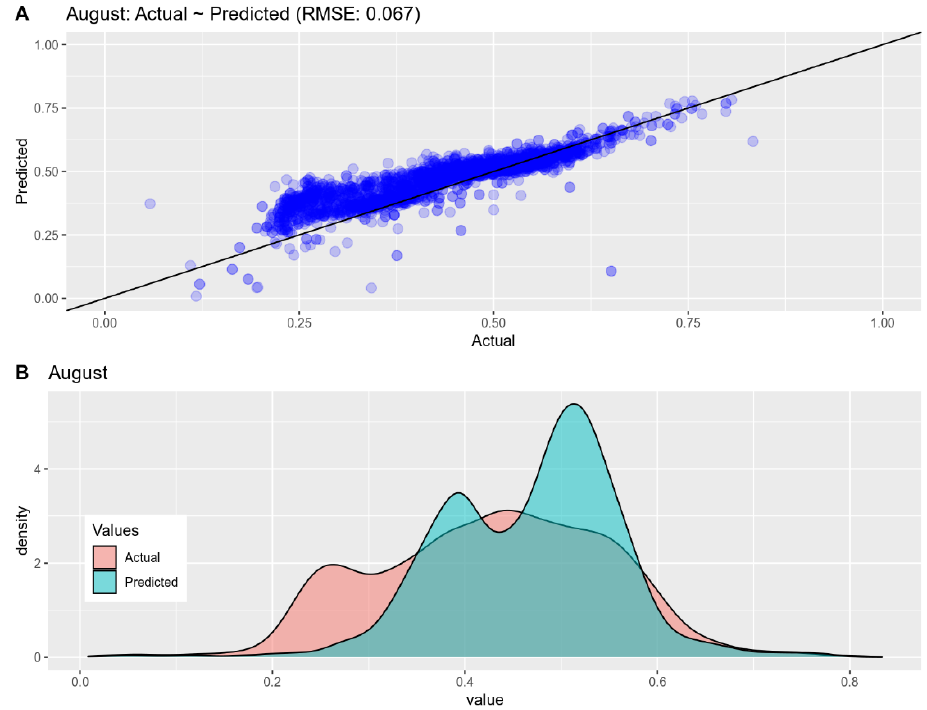
Figure A8. Comparison between actual~predicted for August 2020.